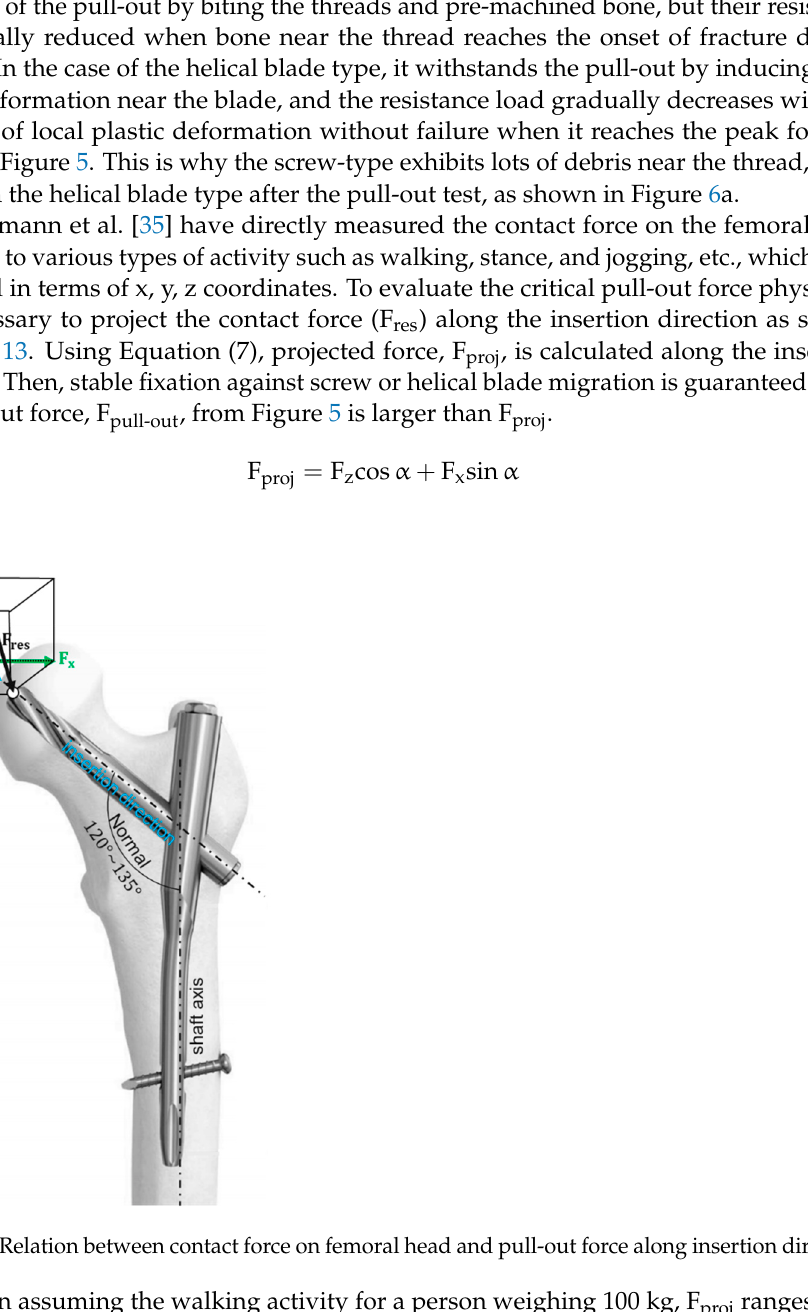
0 Figure 14. Comparison of projected force and pull-out force. 4. Conclusions This paper mainly compares the fixation performances of cephalomedullary nail in terms of the pull-out force when applying screw and helical blade types with respect to femur bone densities. It is substantially important to guide which types of fixation are applied during the operation, since it tends to induce the backout or migration of helical blade and screw depending on the weight and bone density under the fully tightened condition. To compare the pull-out forces between the normal person and an elderly per- son who has osteoporosis, two different densities of biomedical PUR foam blocks are uti- lized. The pre-installed screw or helical blade is pulled out while tracking the pull-out load until the final failure occurs. To make a physical comparison of the critical fixation